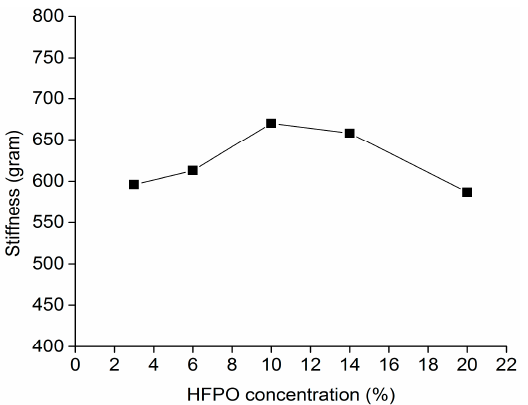
Figure 4. The stiffness of Nomex ® /cotton fabric treated with 3% BTCA and HFPO at different concentration, cured at 170 °C for 3 min and finally subjected to one home laundering cycle.